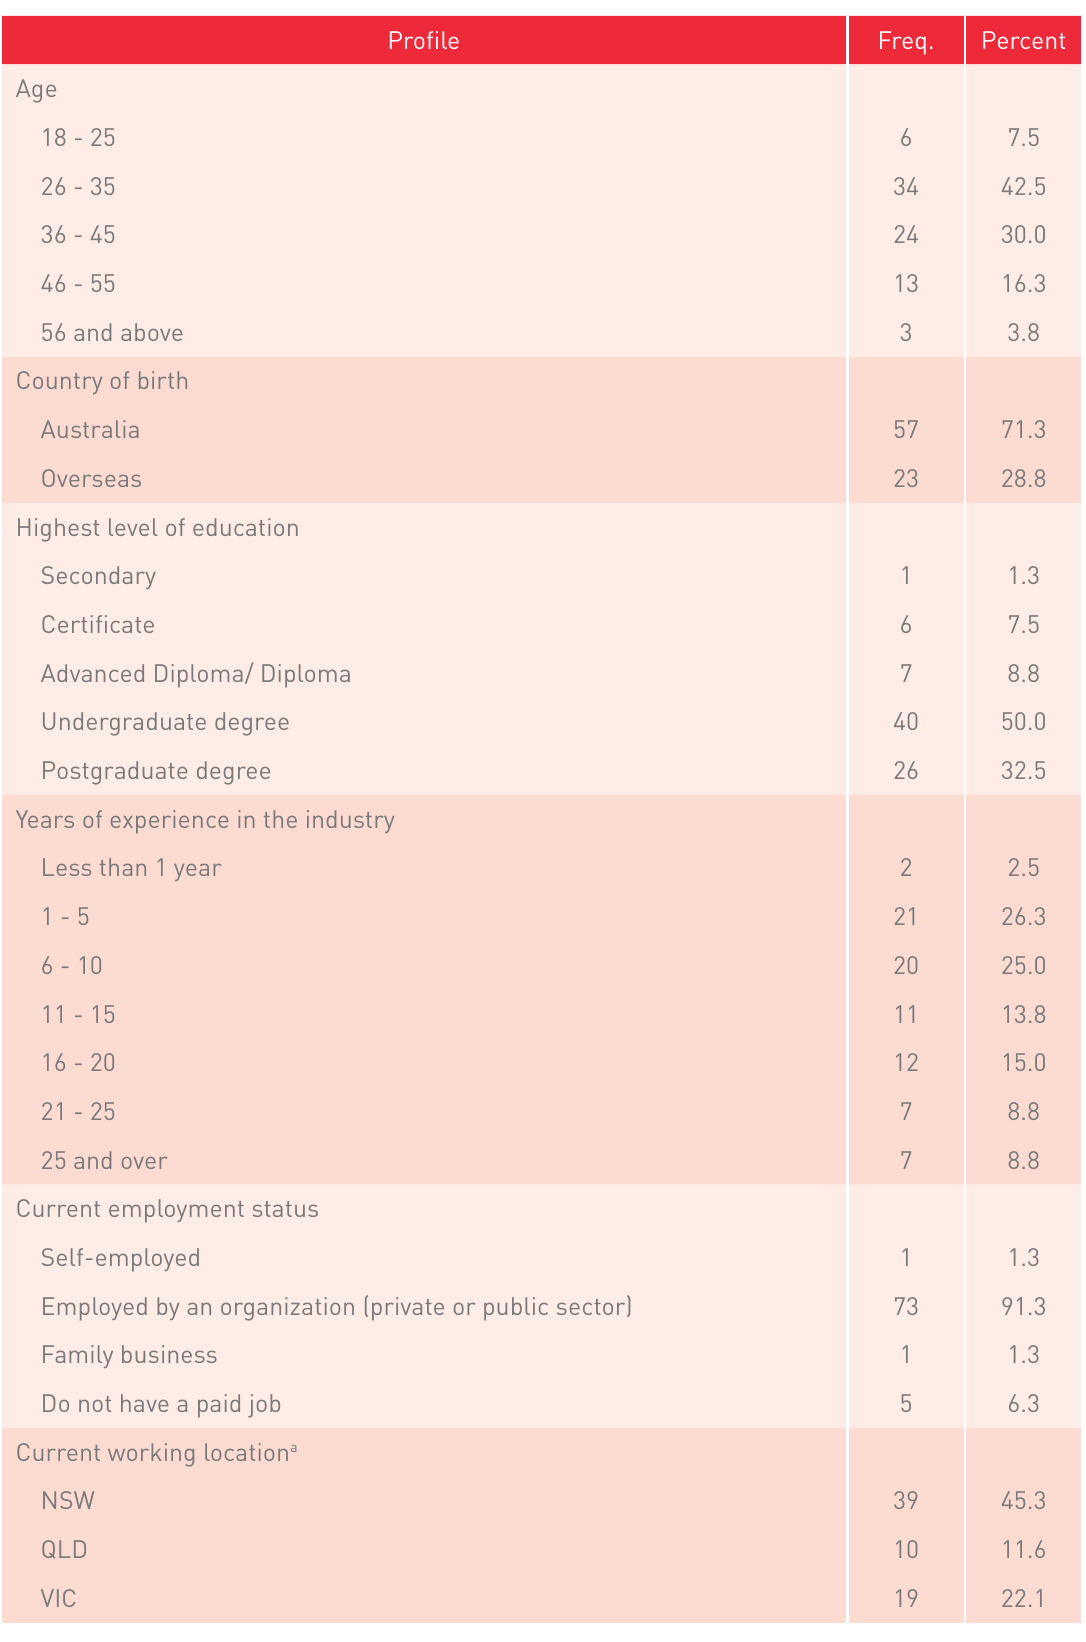
The respondents’